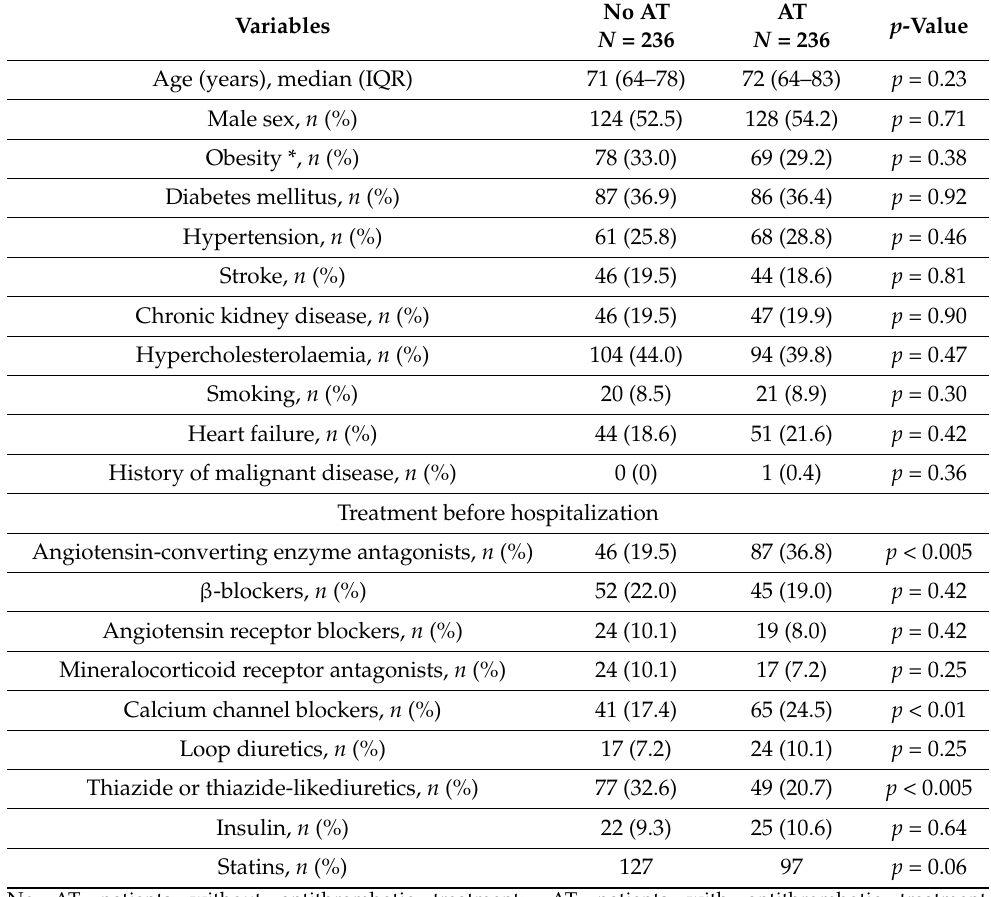
Table 2. Baseline characteristics in matched patients’ populations.